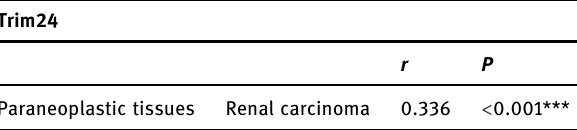
Table 2: Relationship between Trim24 in renal carcinoma and paraneoplastic tissues Trim24